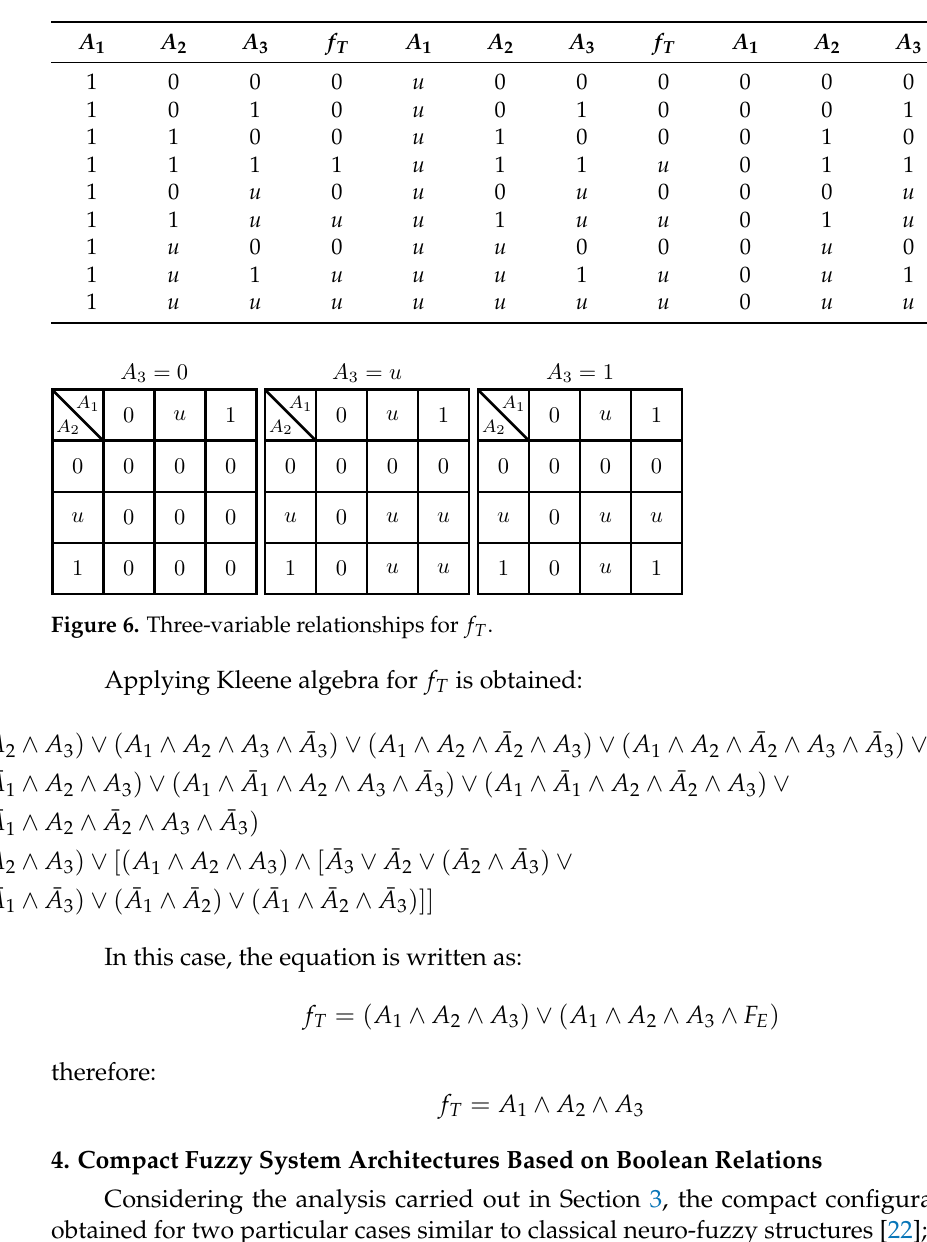
Table 14. Kleene relations for three variables.